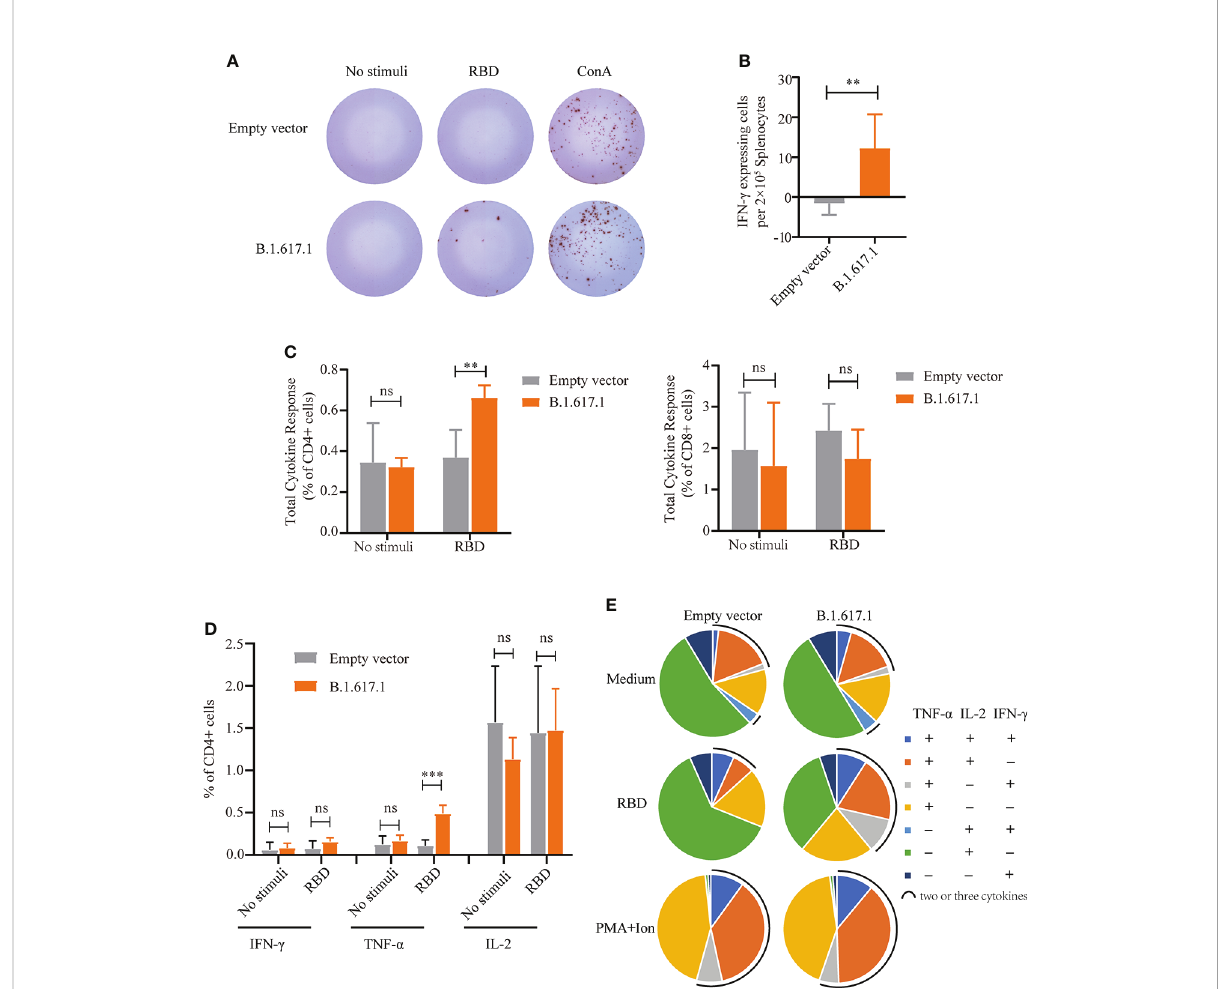
FIGURE 5 Cellular immune responses in splenocytes from mice vaccinated with yeast surface-displayed B.1.617.1 mRBD. (A) The appearance of IFN- g - expressing spots in an ELISpot assay plate. Each dot represents a single cell secreting IFN- g . (B) Level of IFN- g expression per 2 × 10 5 splenocytes. (C) The total cytokine response on fl ow cytometry with intracellular cytokine staining 5 weeks after the fourth immunization or 120 days after priming. The levels of IFN- g , IL-2, and TNF- a secretion by CD4 + and CD8 + T cells were quanti fi ed for each group and expressed